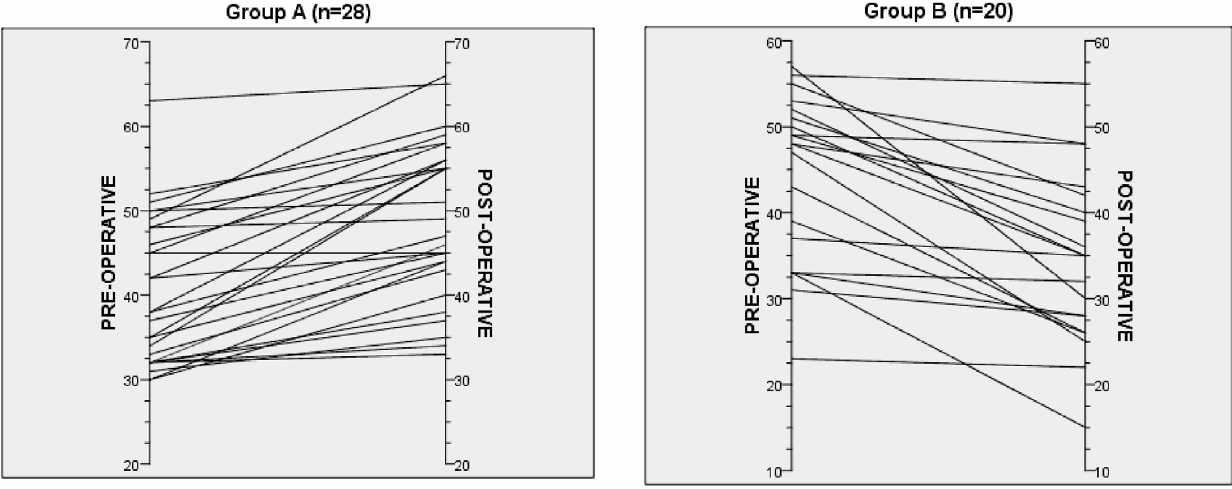
Figure 1. FOF-10 scores before and 1 year after surgery. Group A had improved or the same scores and Group B had worsening on follow-up.